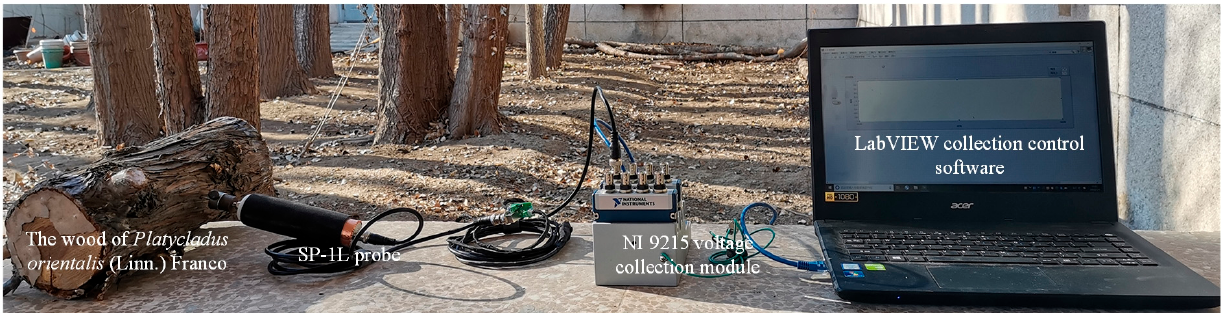
Figure 1. The instruments for data recording.